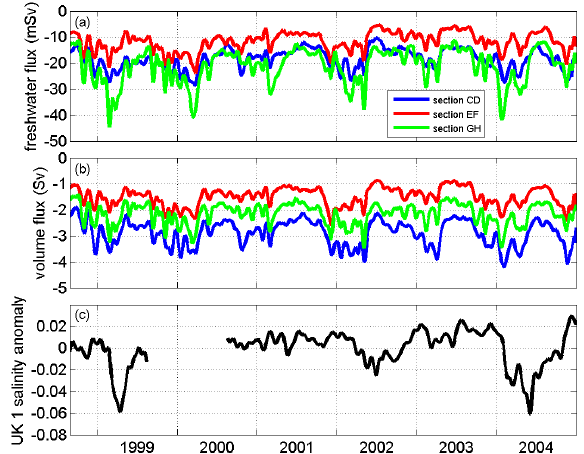
Fig. 15. Time series of freshwater flux (a) and volume flux (b) , across sections CD, EF and GH shown in Fig. 10b. Freshwater flux has been calculated relative to a reference salinity of 35.2. Freshwater flux and volume flux have been integrated between depths of 150 m and 600 m, to correspond with the depth of the Intermediate EGC water feeding the overflow. UK1 salinity anomaly time series is shown in (c) .